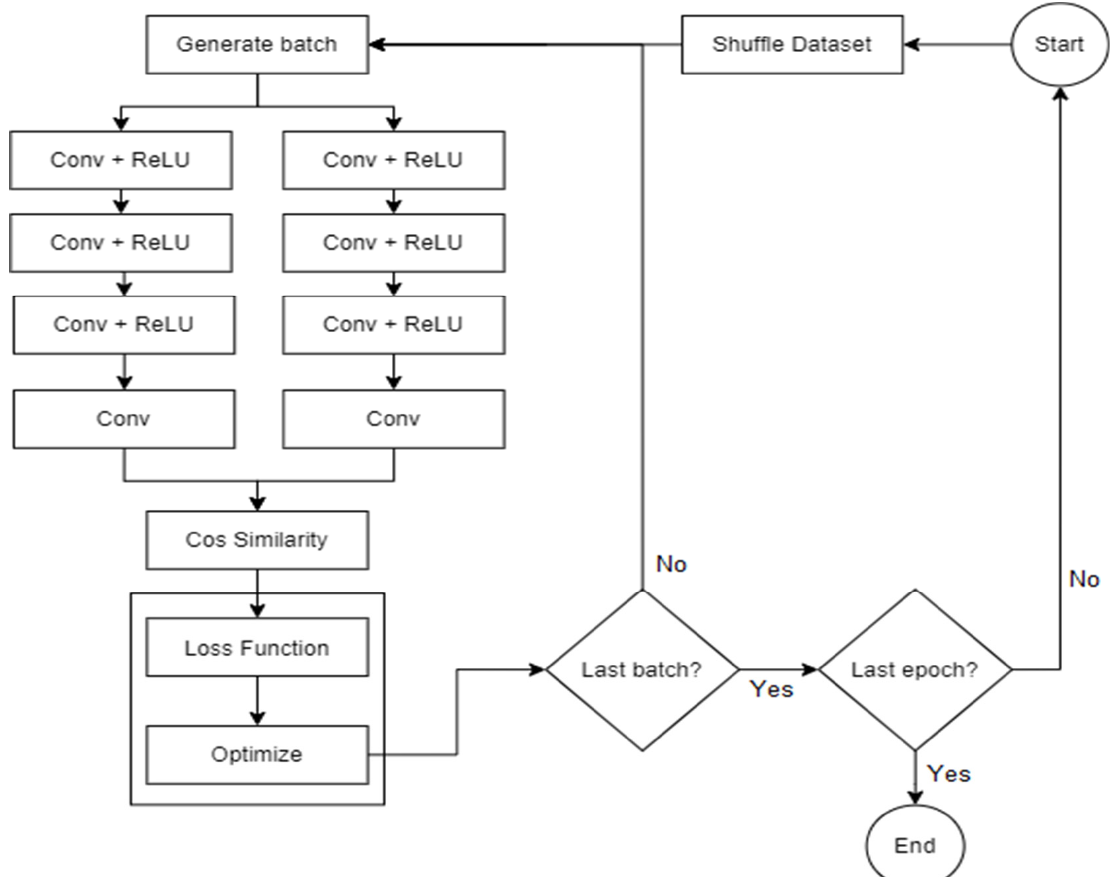
Figure 4. Training flowchart.